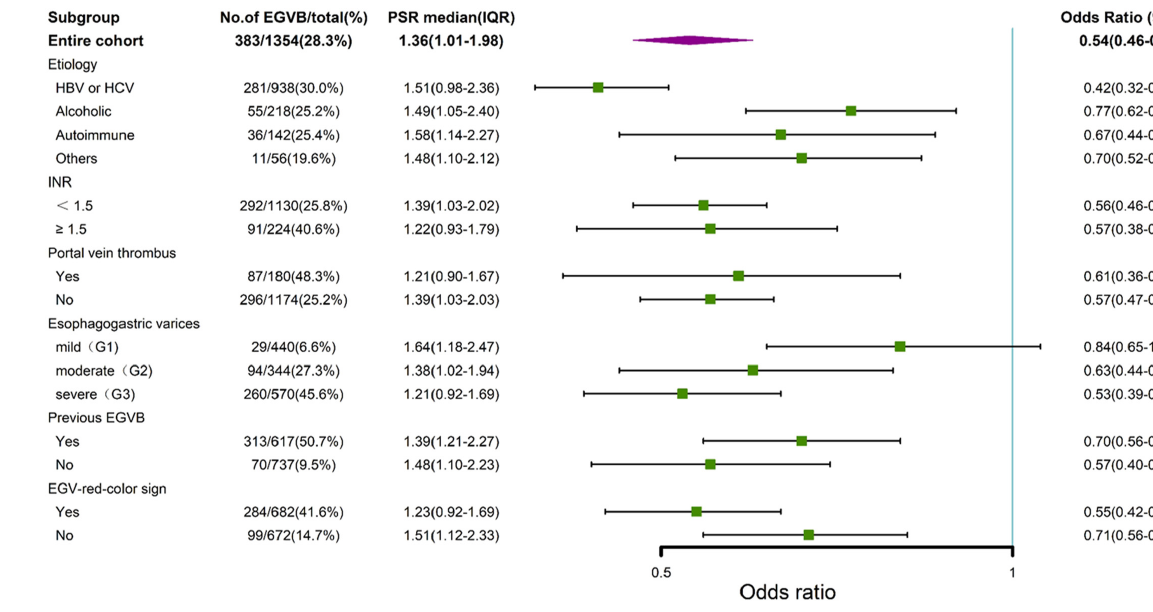
FIGURE 3 | Stratified analysis by forest plots for the platelet count to spleen thickness ratio and variceal bleeding in cirrhotic patients with esophagogastric varices. EGVB, esophagogastric variceal bleeding. G1, mild grade of esophagogastric varices; G2, moderate grade of esophagogastric varices; G3, severe grade of esophagogastric varices; EGV, esophagogastric varices; 95% CI, 95% confidence intervals; PSR, platelet count to spleen thickness ratio.